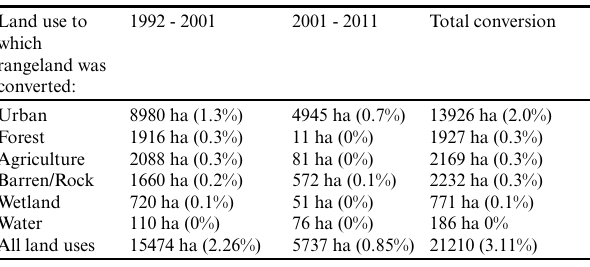
Table 1. Area (ha) and proportion (%) of rangelands converted to other land uses in San Diego County, California, USA, 1992-2011.